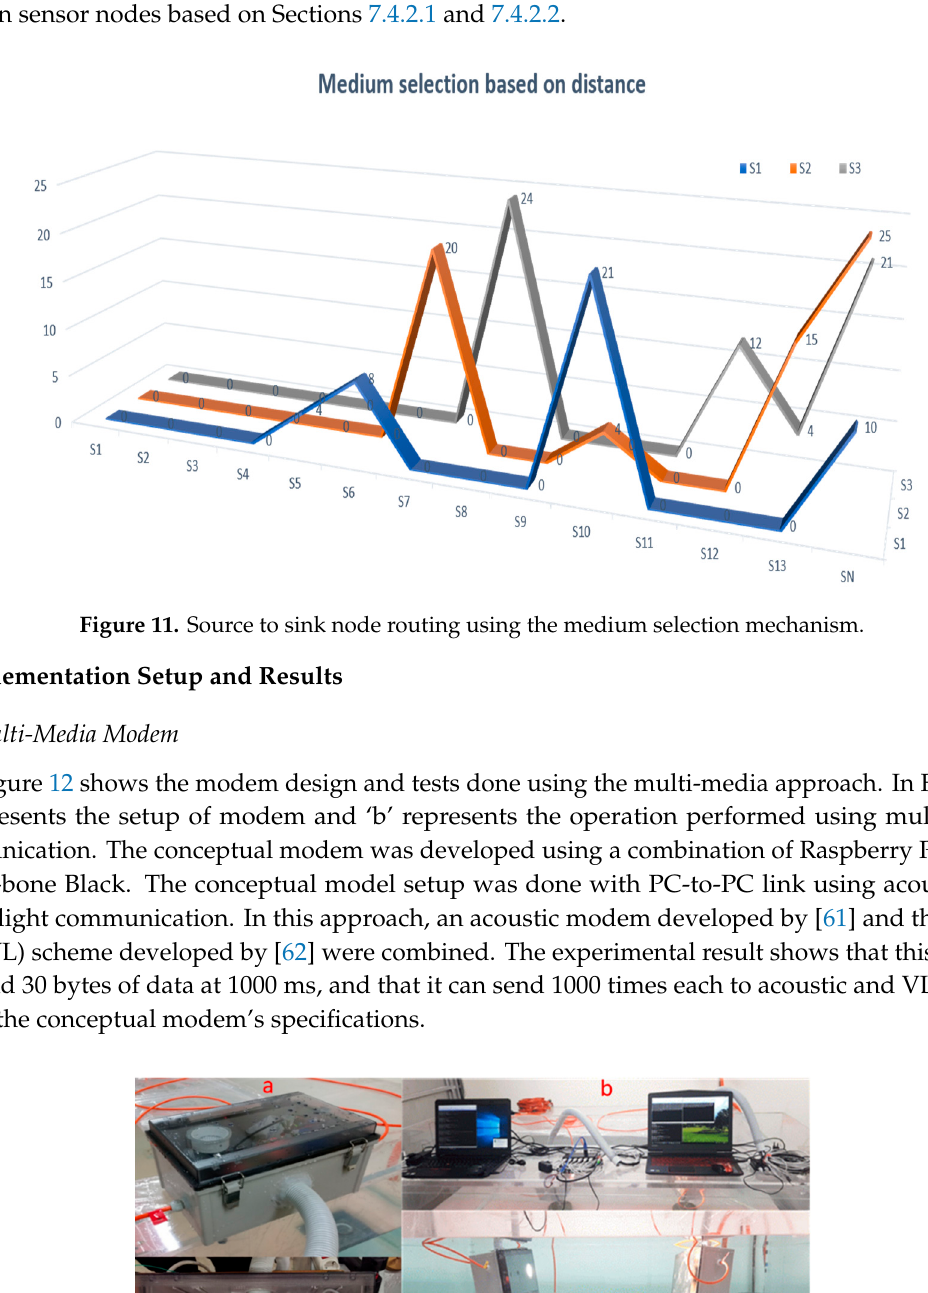
Figure 12. Multi-media modem setup and